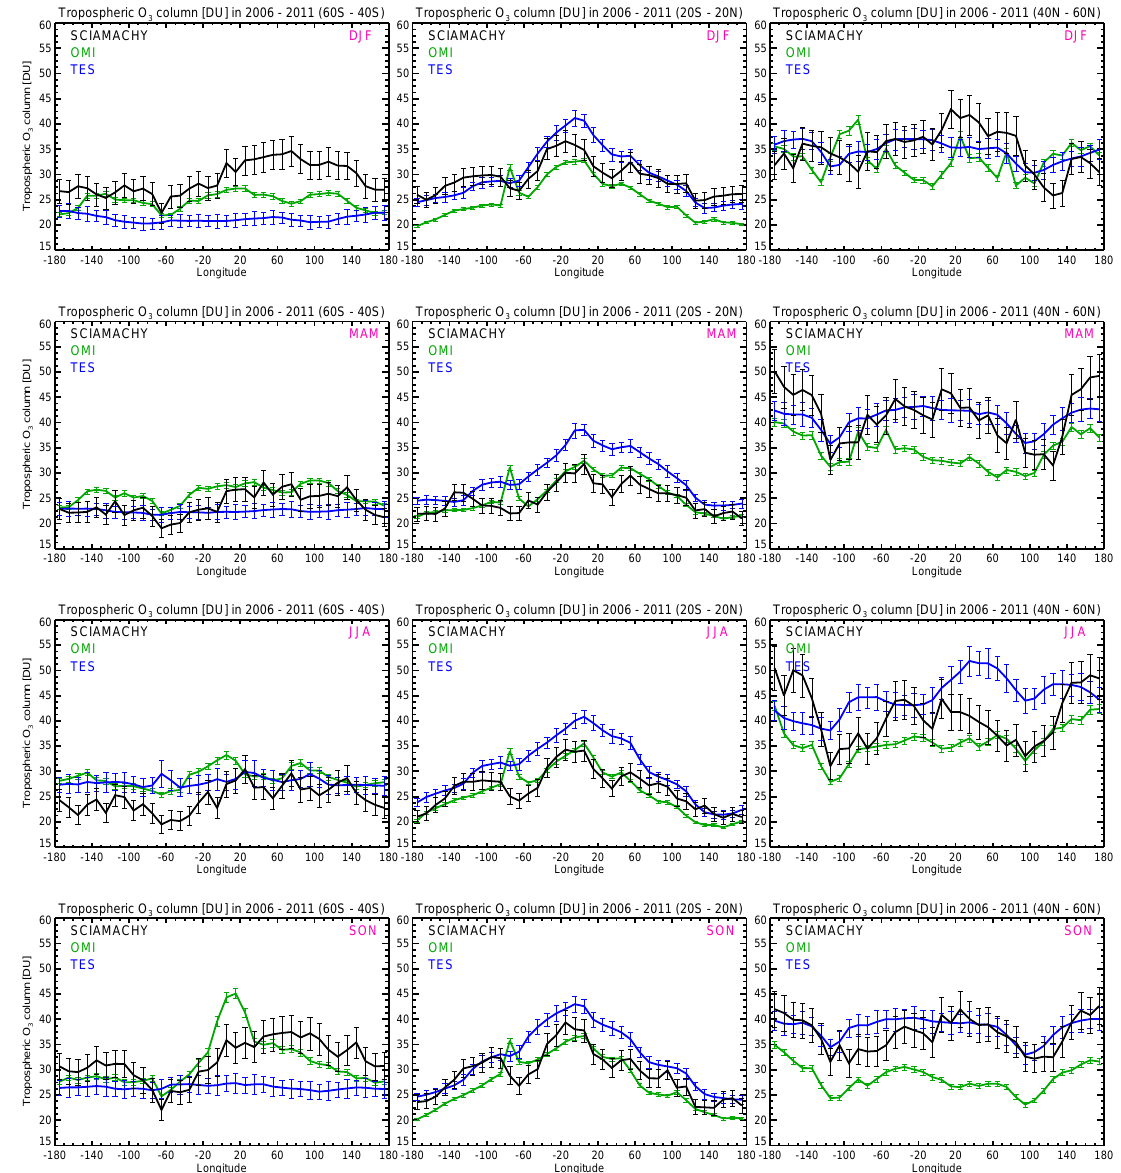
Fig. 12: Line plots of TOC (in DU) as a function of longitude retrieved from the measurements of OMI/MLS, SCIAMACHY and TES; from left to right are the latitude bins 60S-40S, 20S-20N and 40N-60N, respectively averaged from December 2005 to November 2011; from the top panels to the bottom panels; the average composite for December-January-February, March-April-May, June-July-August and September-October-November are shown. Also included in the plots are ± 2 σ vertical bars used as estimates of variability of monthly zonal means, where σ is the calculated 6-year rms standard error of the mean. 38